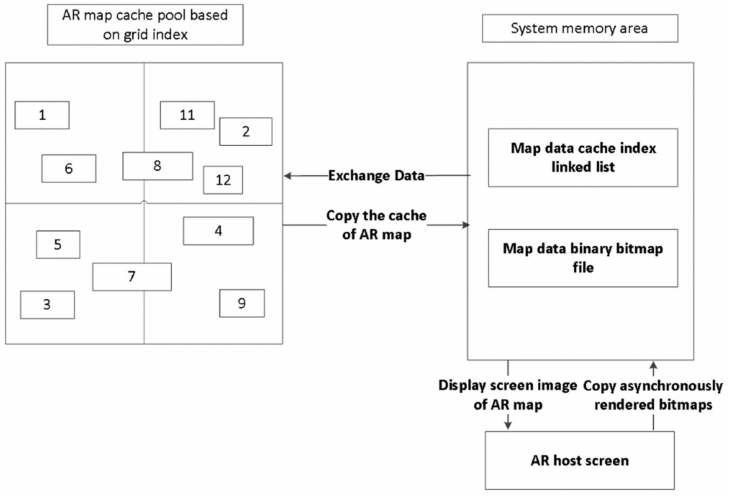
Figure 6. Asynchronous update method for AR vector maps with no latency.